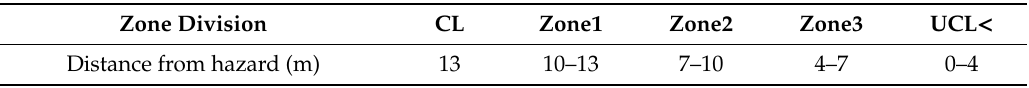
Table 2. Statistical zone division.